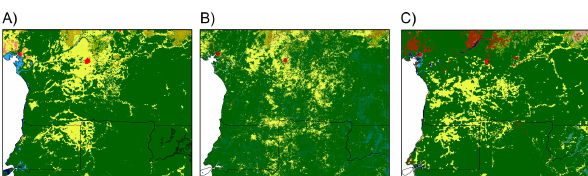
Fig. 9. Example of the improved discrimination of vegetation classes using the 8-yr SPOT VGT time series analysis depicting networks of deforested areas usually not detected due to the per- sistent cloud coverage. (A) Congo Basin Vegetation types map (B) GlobCover (300m resolution) (C) GLC 2000 (1km